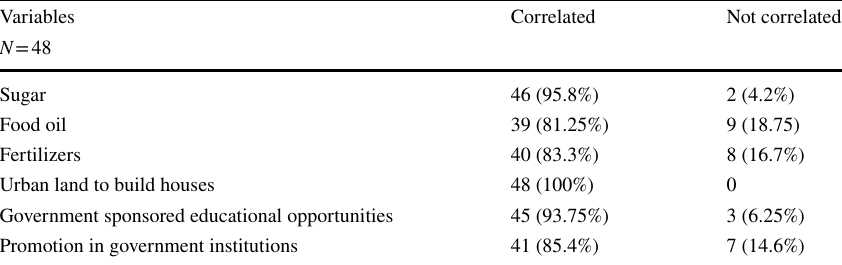
Table 6 Participants’ views on the correlation between political views and state operated services and supplies in southwest Ethiopia Variables